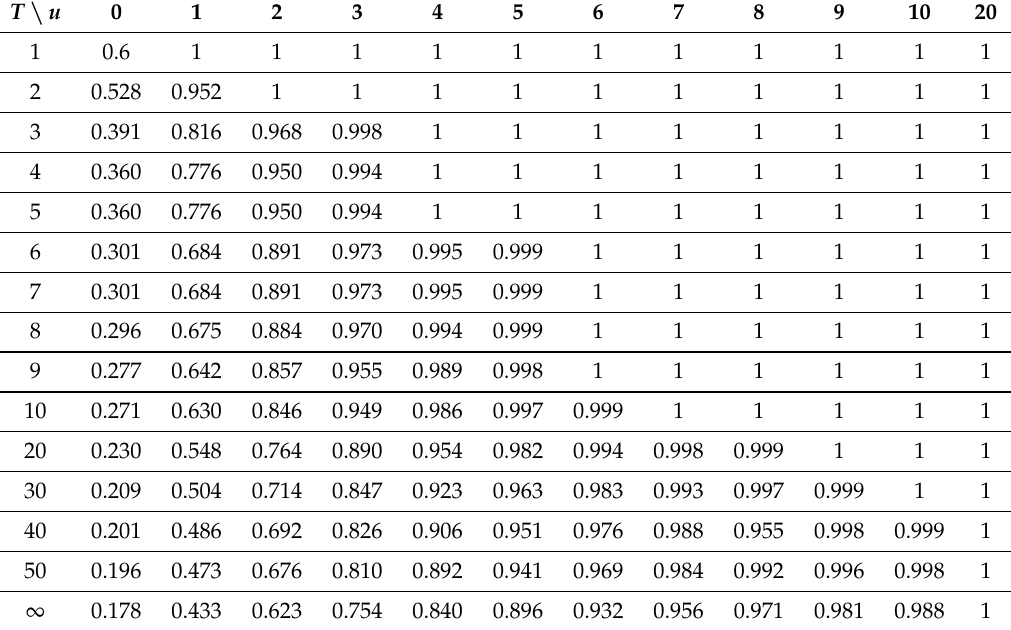
Table 9. Values of survival probabilities for the model described in Example 5. T \